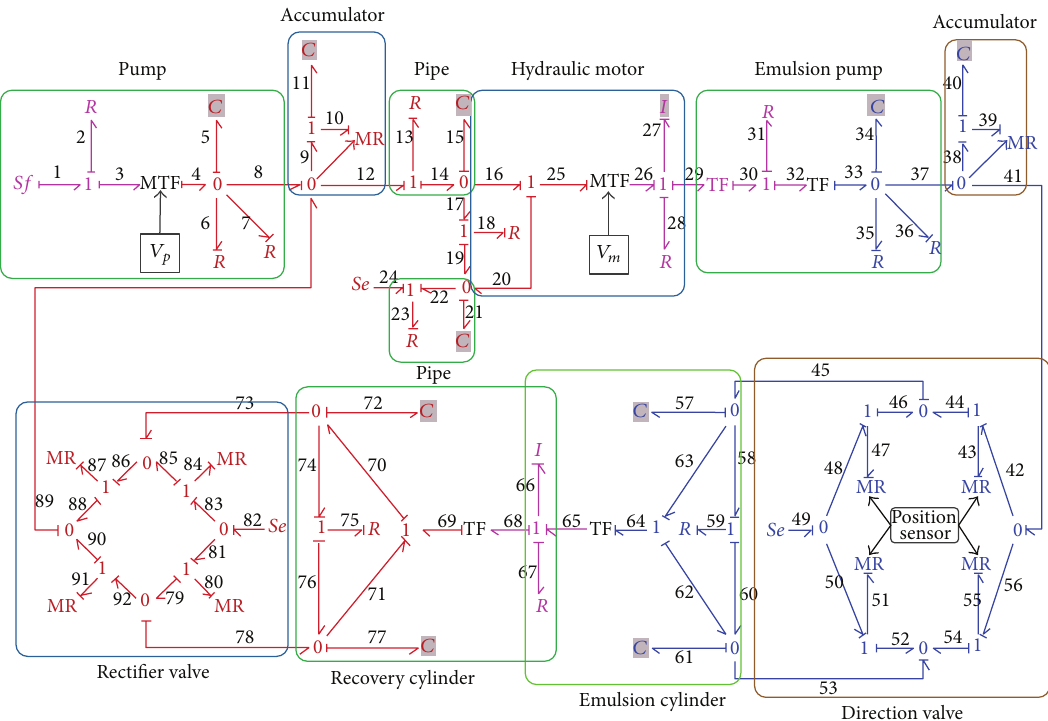
Figure 10: Bond graph model of the overall